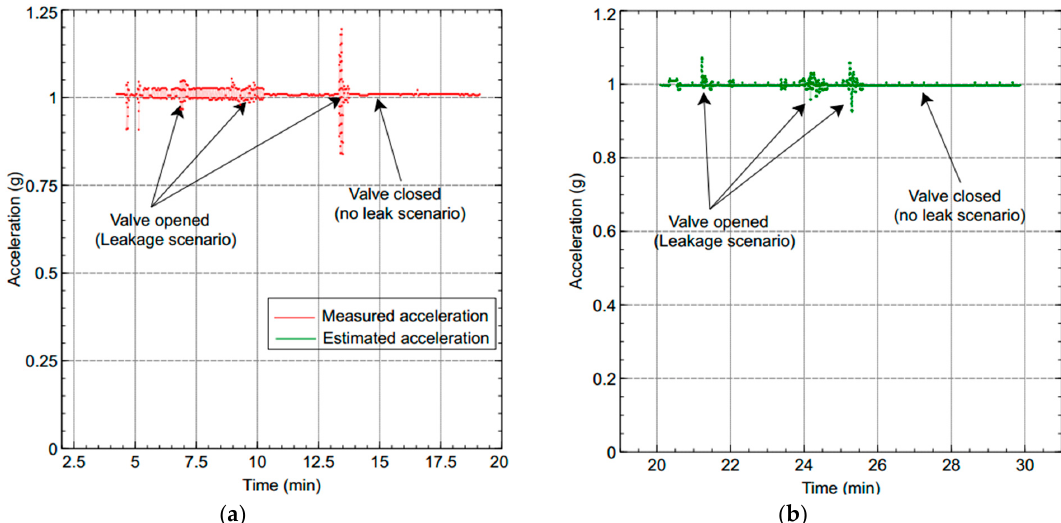
Figure 11. Estimated acceleration of Node 00 obtained from Distributed Kalman Filter (DKF) implementation ( a ) with measured acceleration and ( b ) without measured acceleration .